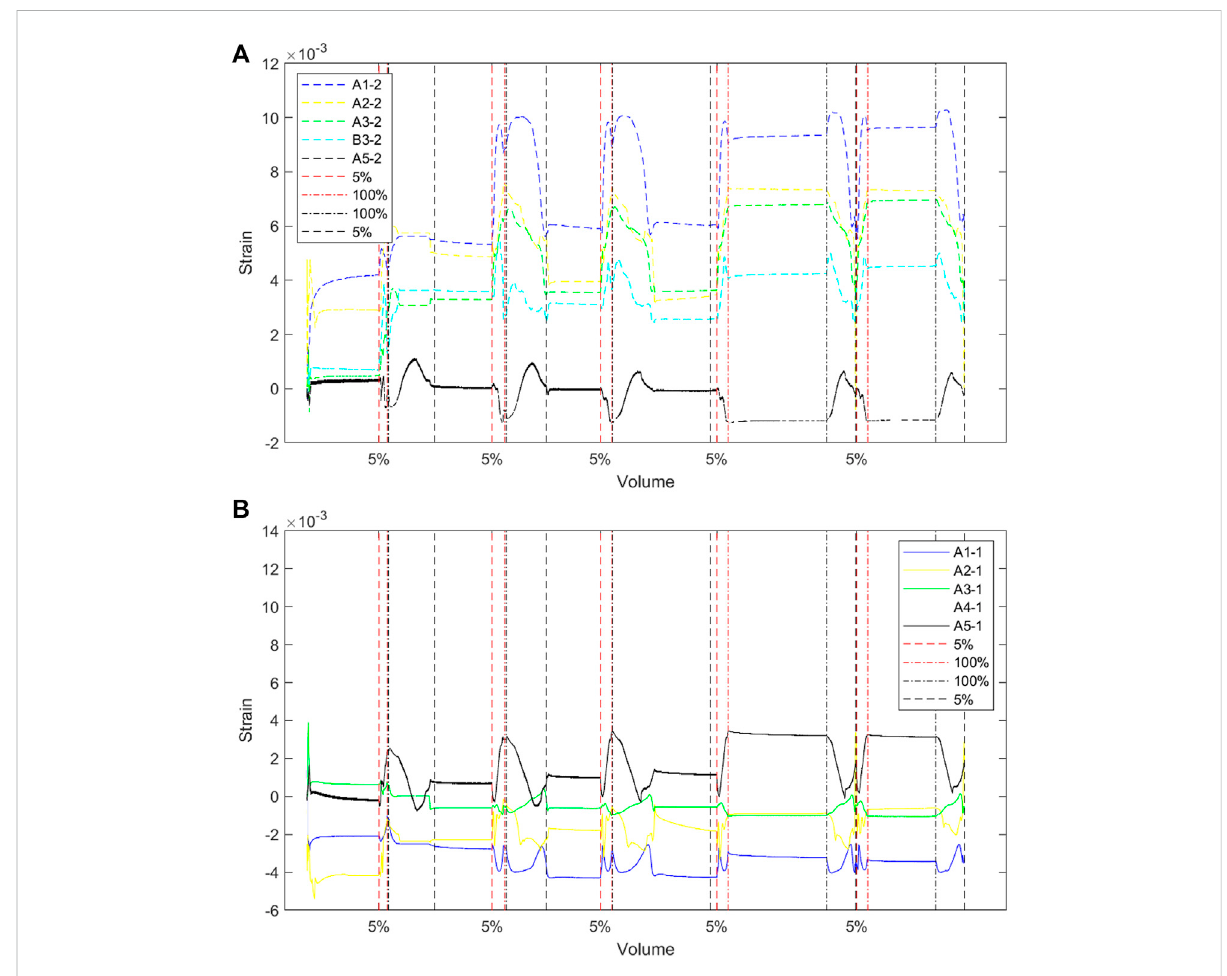
FIGURE 10 Strain of the sensor on the membrane: (A) longitudinal direction; (B) latitudinal